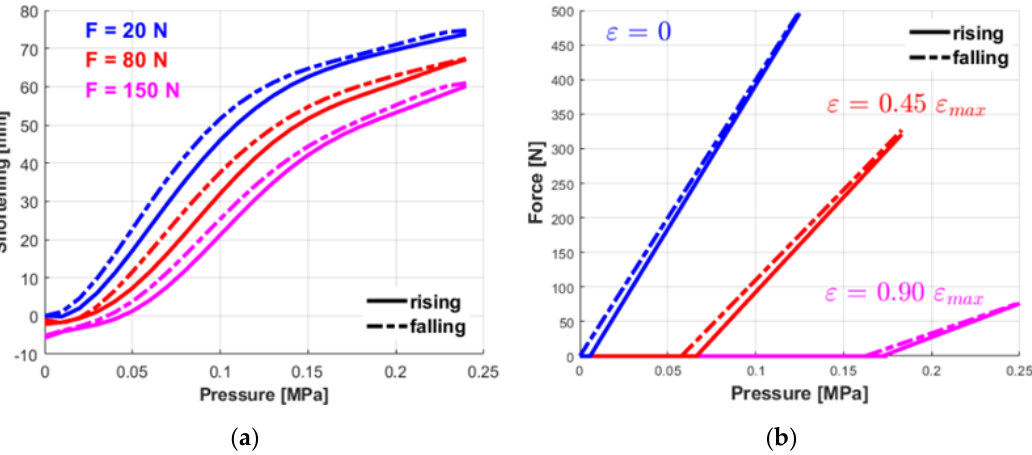
Figure 2. Characteristic curves of the MKM operating modes. Panel ( a ) the isotonic working mode for three different values of the exerted force F ; Panel ( b ) the isometric working mode for three different shortening constraints ε.